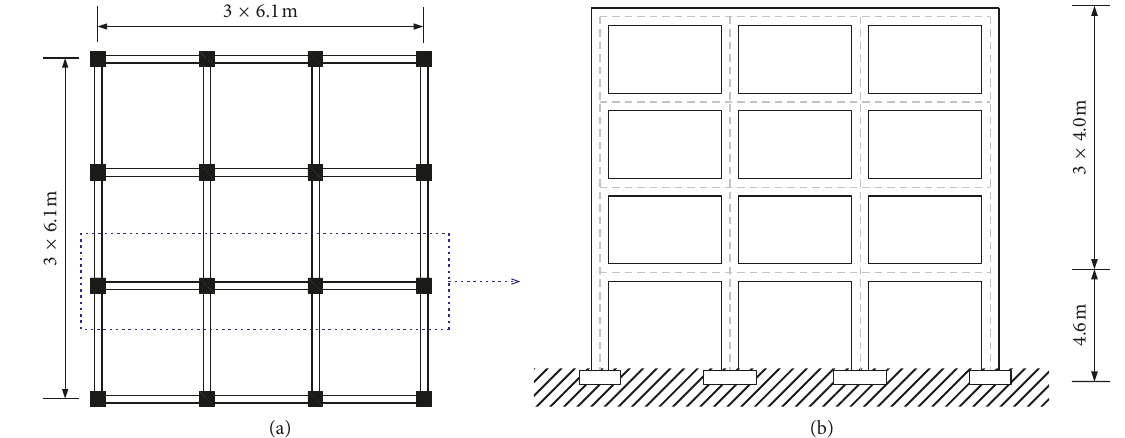
Figure 2: Plan and elevation views of the prototype building. (a) Plan view. (b) Elevation view.